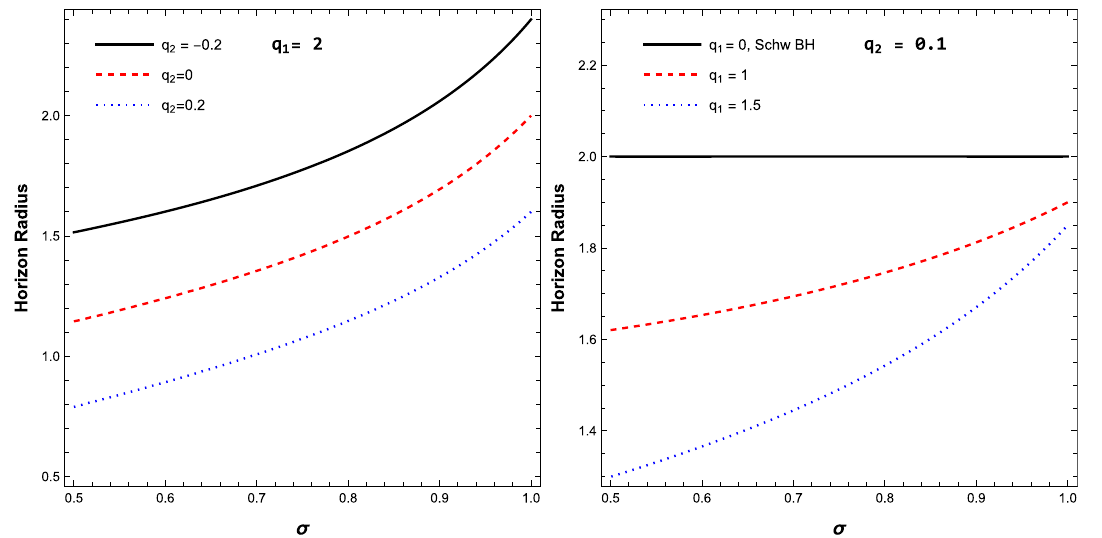
Fig. 3 Variation of horizon radius with increase of the parameter σ for selected values of q 1 and q 2 . In the left plot q 1 is fixed and q 2 takes three different values while in the right plot, q 2 is fixed and q 1 takes three different values. If q 1 → 0, the radius of horizon is the same as the horizon of Schwarzschild BH